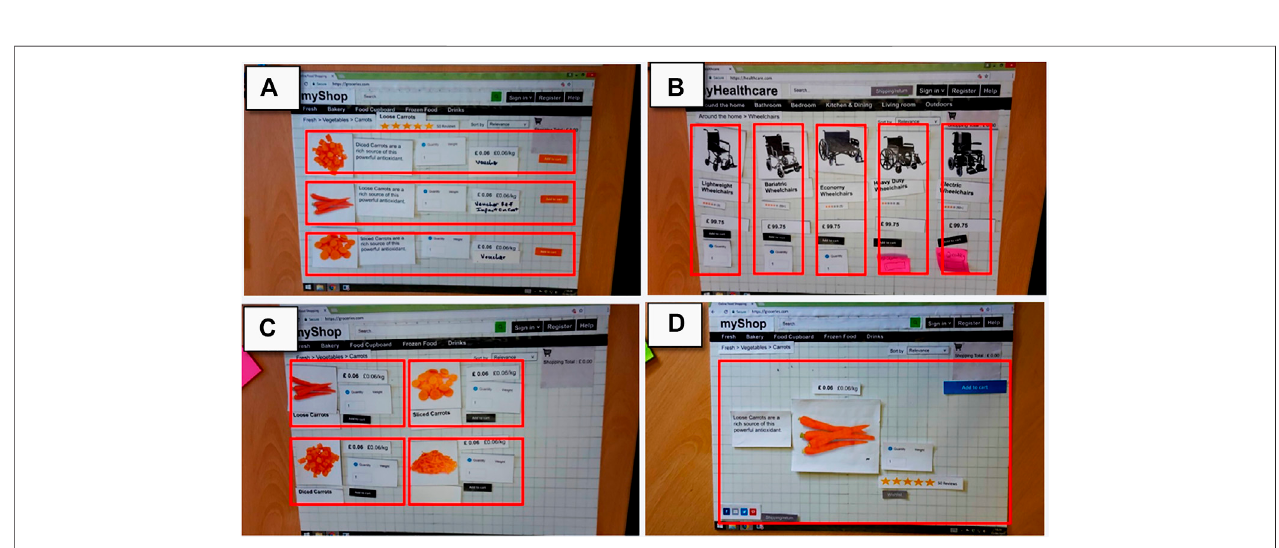
FIGURE 5 | Samples of the layout of pages designed by participants. (A) Horizontal, (B) vertical, (C) grid, and (D) single